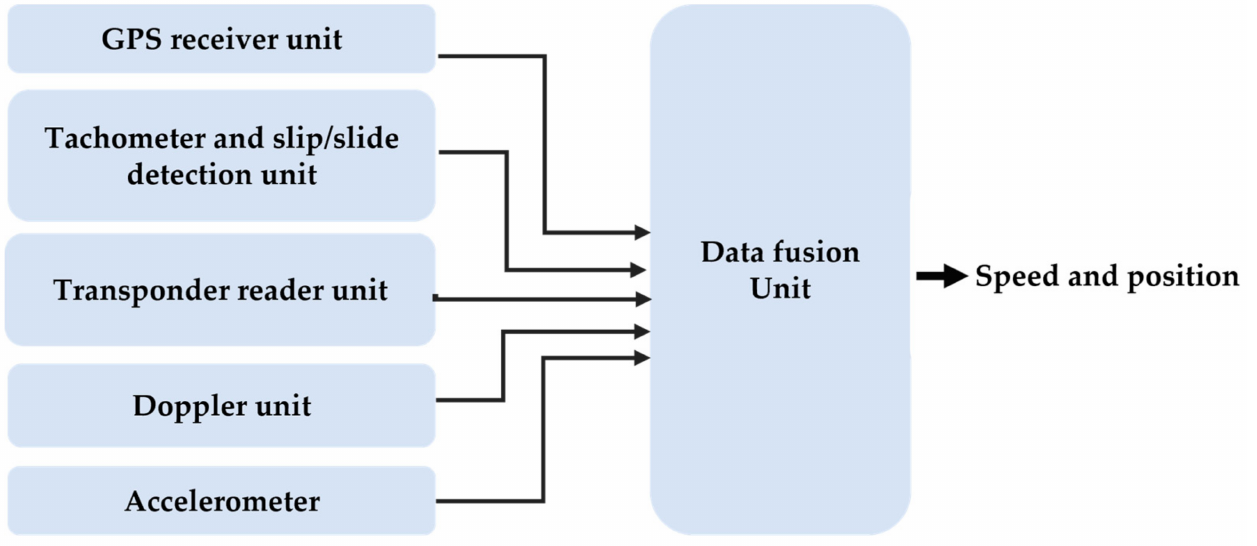
Figure 7. Integration of different sensors for measuring train position and